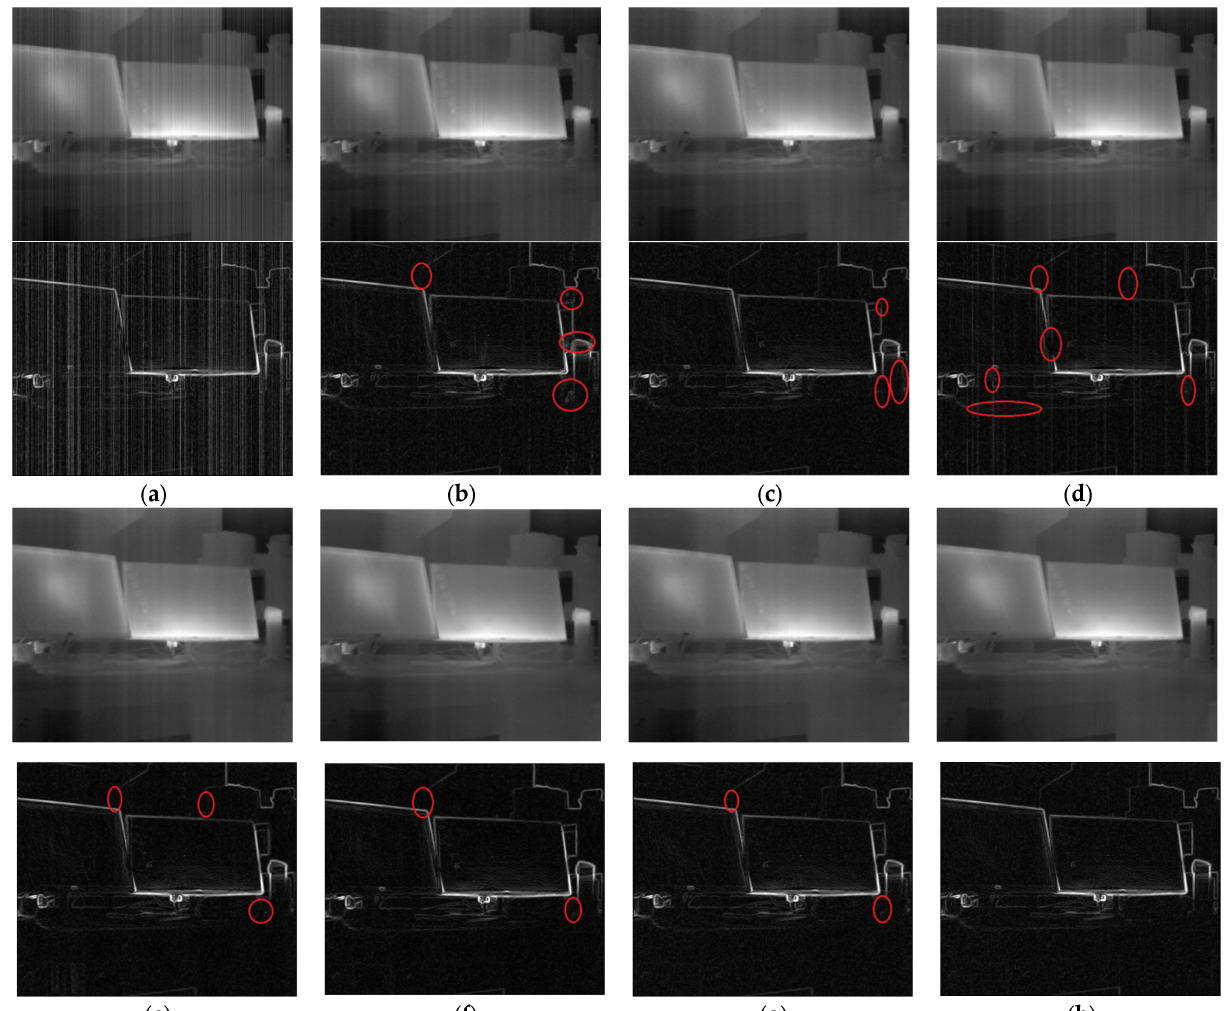
Figure 19. The correction results of the real data 1 and the edge detection images of the correction results. The red circle is our manual annotation of texture details in the image: ( a ) real data 1; ( b ) MHE; ( c ) 1D-GF; ( d ) SNRCNN; ( e ) ICSRN; ( f ) DLS-NUC; ( g ) SNRWDNN; ( h )